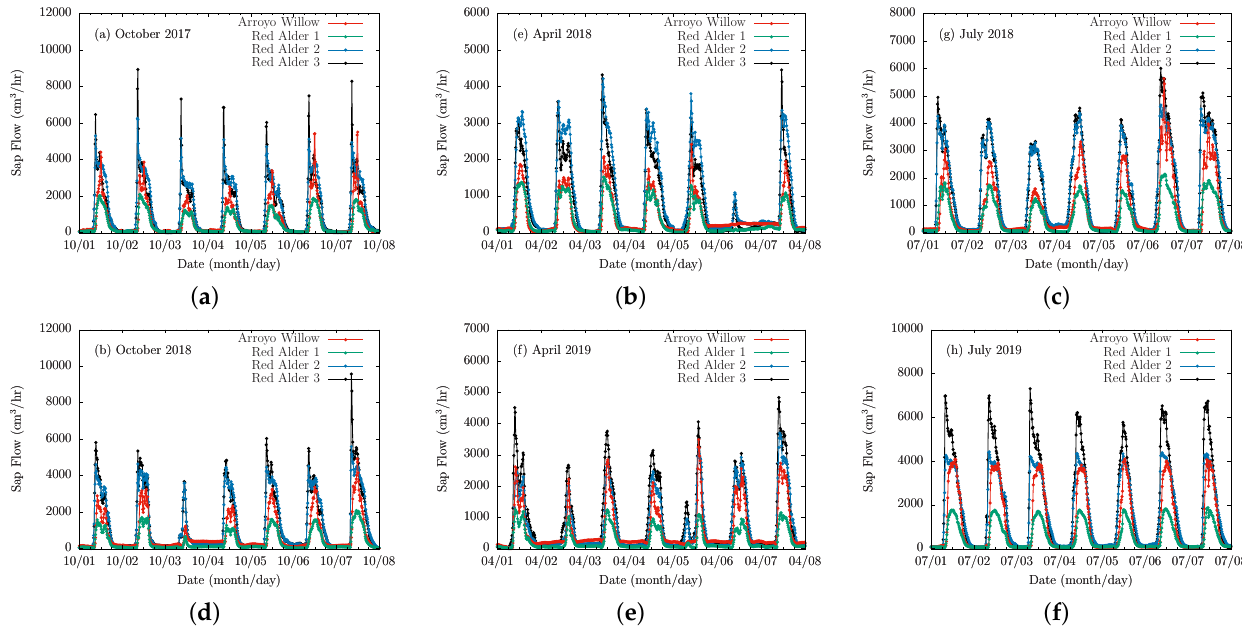
Figure 6. Example weekly sap flow data of the four instrumented trees collected over the two-year monitoring period. The graphs show sap flow measured in ( a ) Fall 2017, ( b ) Spring 2018, ( c )